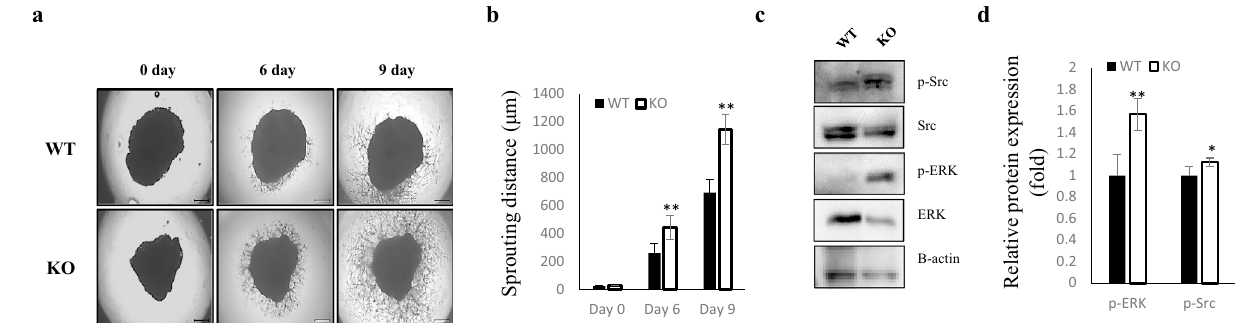
Figure 2. Enhanced capillary sprouting from adipose tissue in TGFBI KO mice. iWAT was dissected from 20-week-old male WT and KO mice and embedded on Matrigel. (a) Capillary sprouts emerging from iWAT were monitored for up to 9 days. Representative images of sprouted capillaries are shown at the indicated days. (b) The distance of capillary sprouting was quantified with Image J software . (c) Cells were isolated from capillary branches on day 9 post-embedding. Total proteins were extracted as described in the “Materials and methods” section. Representative expression of the indicated proteins in isolated primary cells from capillary sprouts in WT and KO mice (n = 3/group). (d) Relative expression of these proteins. Data are presented as the mean ± s.e.m. *p < 0.05, **p < 0.01 versus